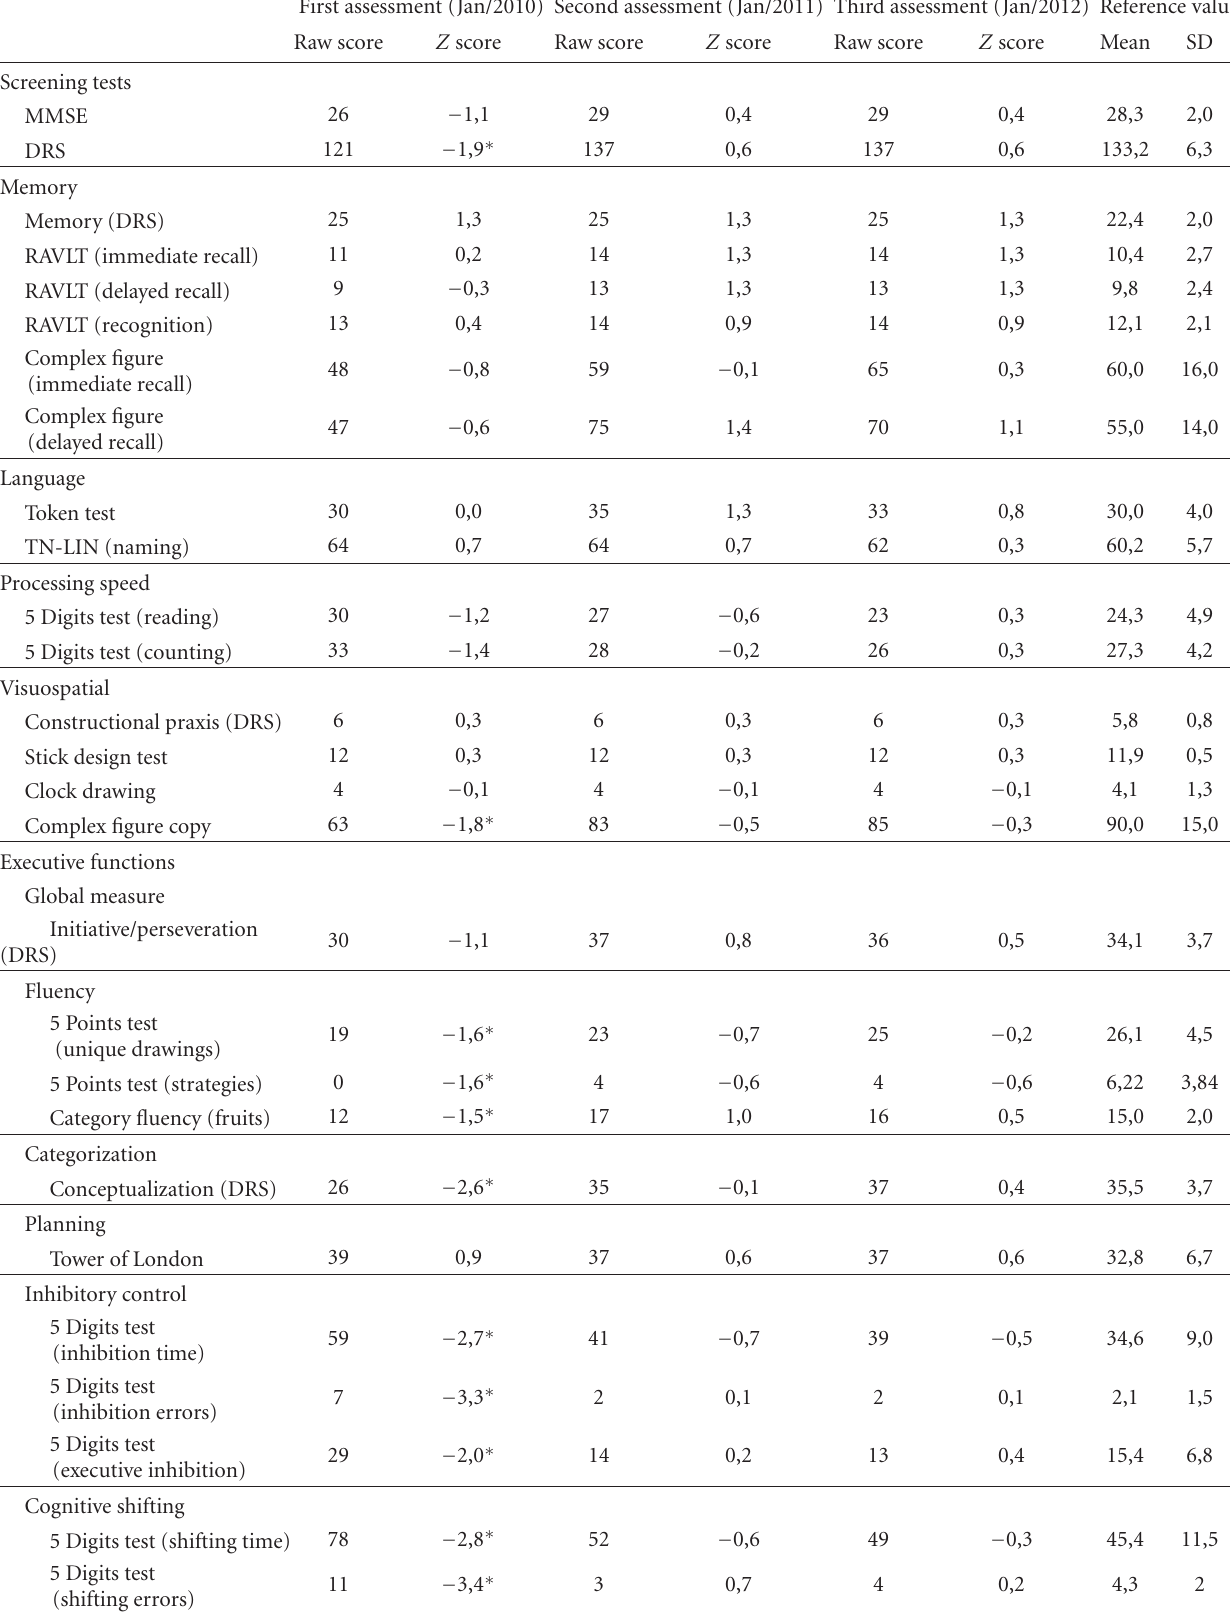
Table 2: Neuropsychological